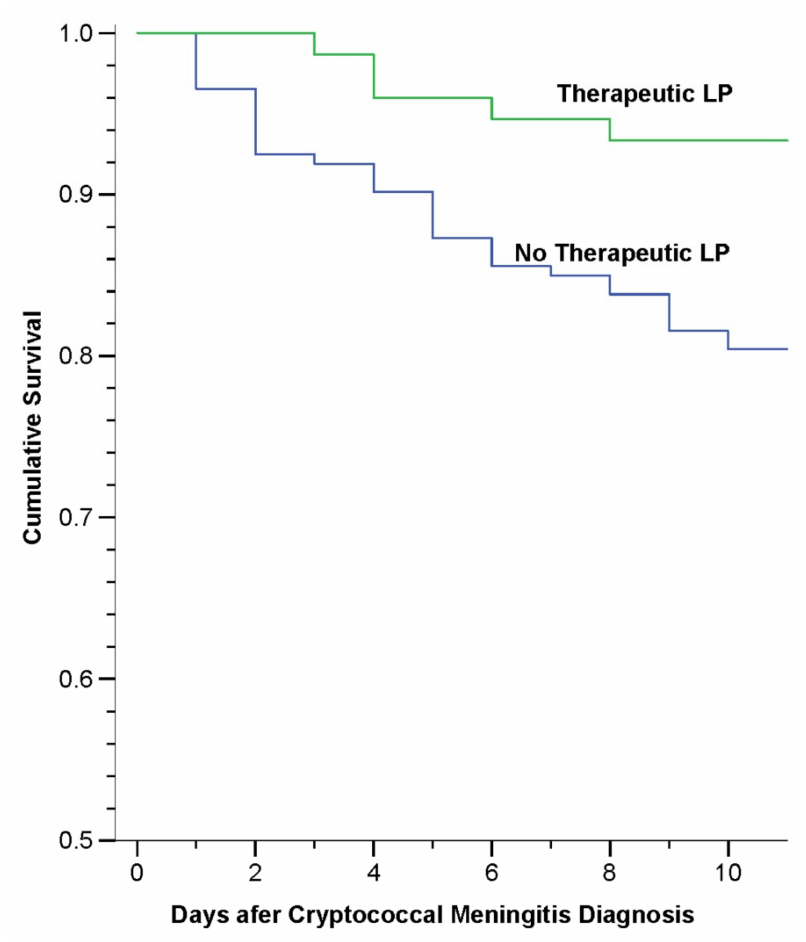
Figure 2. Ten-Day Survival by Receipt of at Least One Therapeutic Lumbar Puncture (LP) [62]. Figure 2 is adapted from Rolfes et al. [62] to display the mortality with and without a therapeutic LP conducted during the first week, limited to those who survived > 1 day. The median time to therapeutic LP was 3 days (IQR, 2–4 days). Thirty-one deaths (18%) occurred among 173 individuals without a therapeutic LP and 5 deaths (7%) among 75 with at least 1 therapeutic